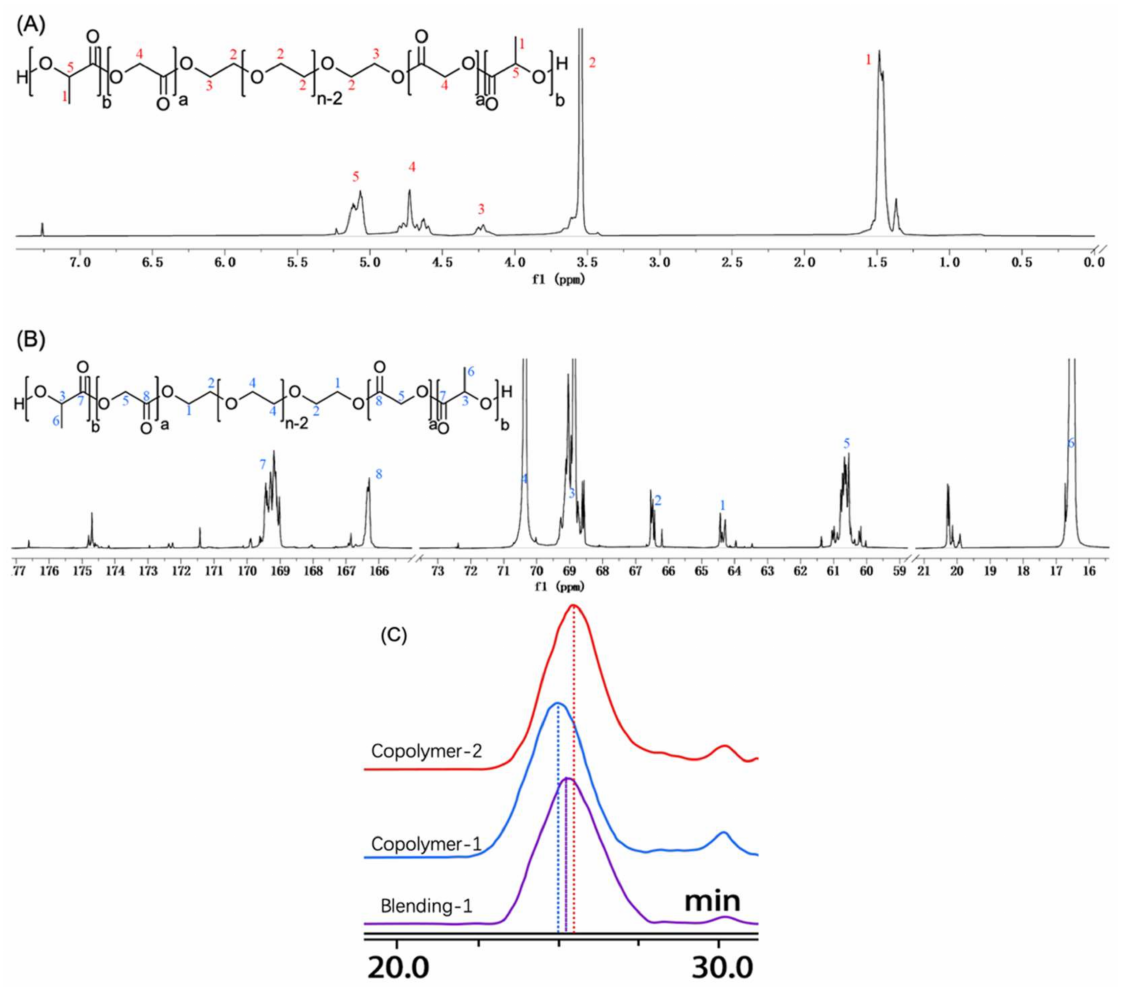
Figure 4. 1 H–NMR ( A ), IGD 13 C–NMR ( B ) spectrum of PLGA–PEG–PLGA and analysis of each peak integration. GPC diagram ( C ) of Copolymers and B–1. Table 1. Molecular characteristics of series PLGA–PEG–PLGA calculated from 13 C–NMR and